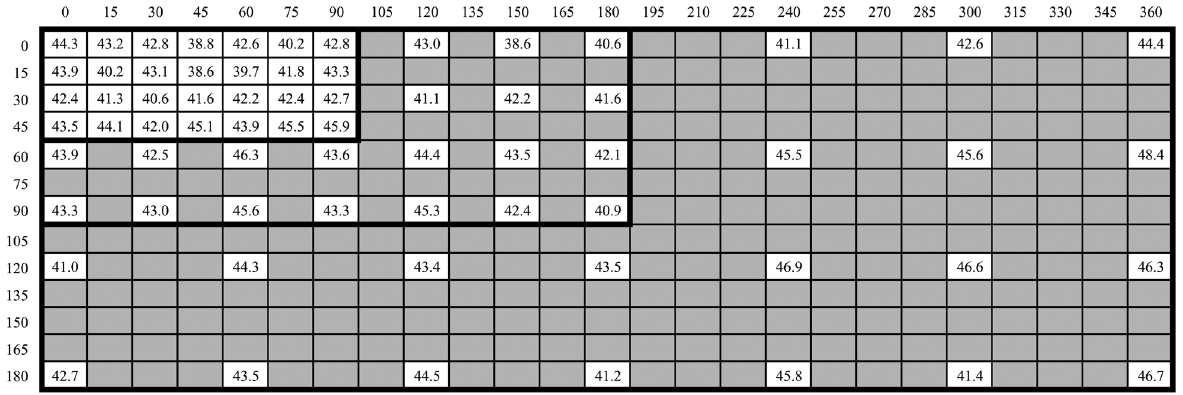
Fig. 3. Arrangement of the testing locations together with the average values of the rebound indices for the N-type Silver Schmidt rebound